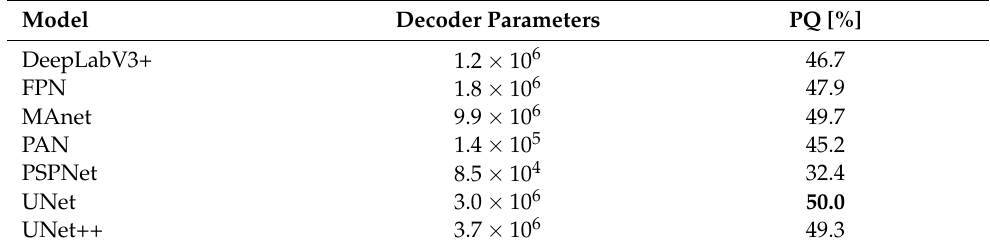
Table 4. Influence of various model architectures on panoptic quality